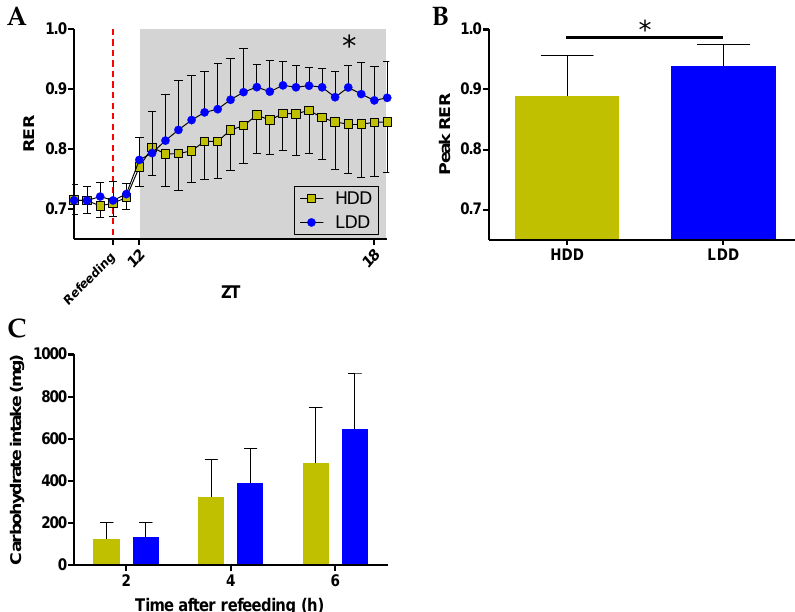
Figure 4. Metabolic flexibility of female mice after eight weeks of HFD feeding (PW 14). ( A ) RER evolution one hour before refeeding until seven hours upon ad libitum refeeding with a high carbohydrate diet (HDD). Statistical comparison was performed on all of the data points from the moment of food restriction (additional data points not shown to enhance visualization). ( B ) Mean peak RER values achieved within seven hours after refeeding. ( C ) Cumulative carbohydrate intake calculated from the automatic records of food intake after access to the refeeding diet. n = 13 for HDD and n = 11 for LDD. Data shown as mean ± s.d. Statistical difference denoted as * p ≤ 0.05.